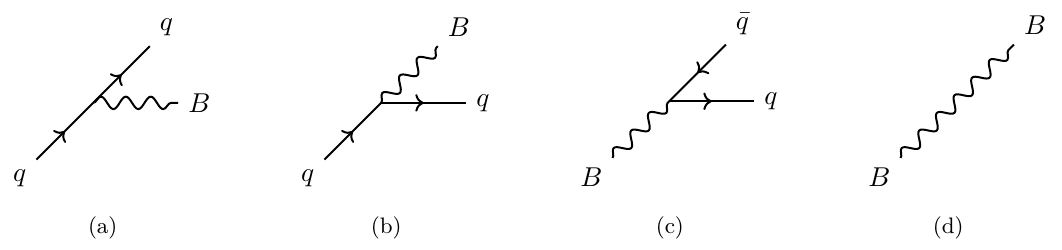
Figure 1 . The diagrams involving dark photons which contribute to splitting functions. (a), (b), (c), (d) show the contributions to P (0 , 0 , 1) ( x ) , P (0 , 0 , 1) ( x ) , P (0 , 0 , 1) ( x ) and P (0 , 0 , 1) ( x ) , respectively qq Bq qB BB (note at this order, P (0 , 0 , 1) ( x ) is proportional to a delta function, δ (1 − x ) , indicating the lack of BB possible splitting in this